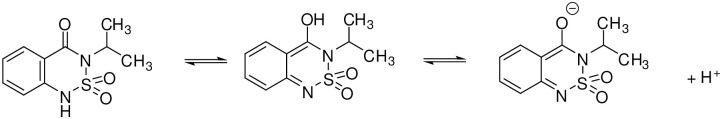
Keto-enol tautomeric equilibrium and dissociation process of bentazone.